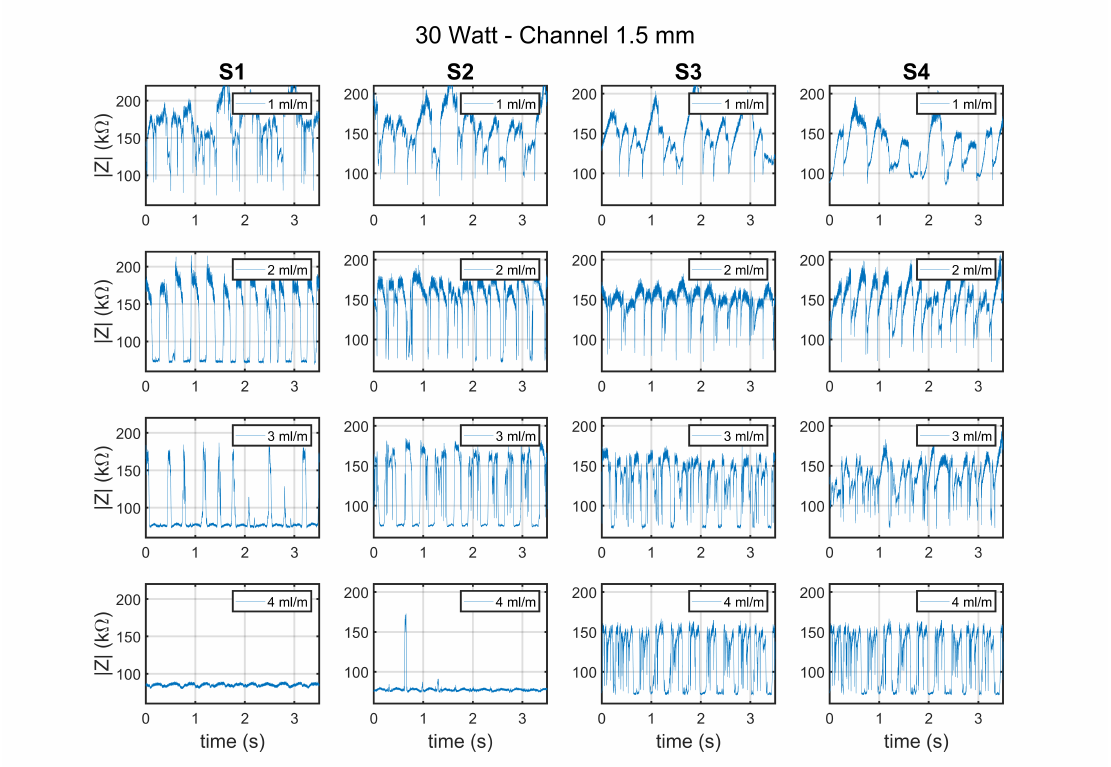
Figure 14. Impedance measurements for 30 W experiments on channel